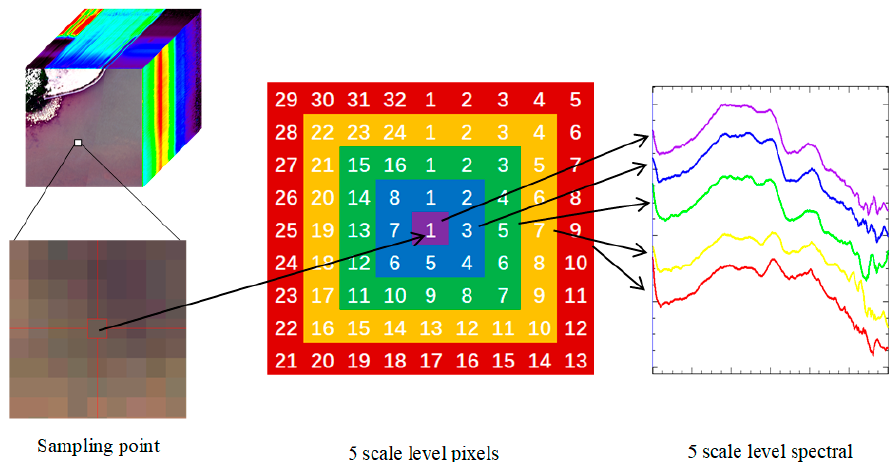
Figure 6. Spectral data sampling method at five scale levels.